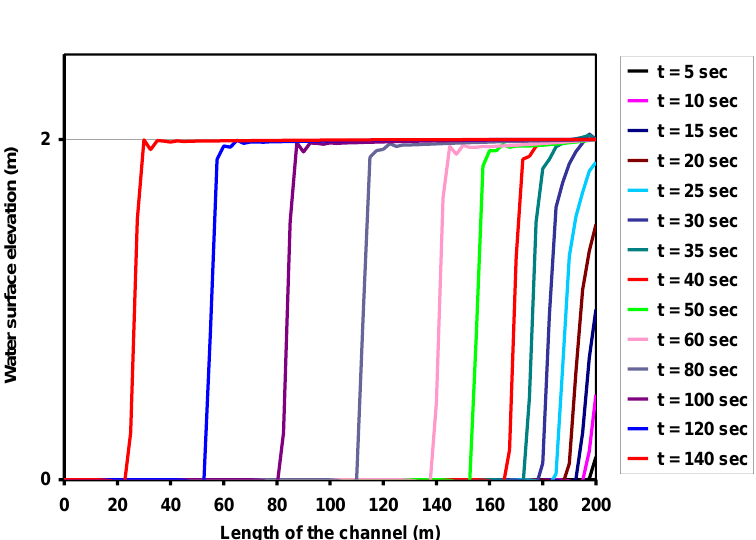
Figure 4. Water profiles along the channel due to bore propagation.